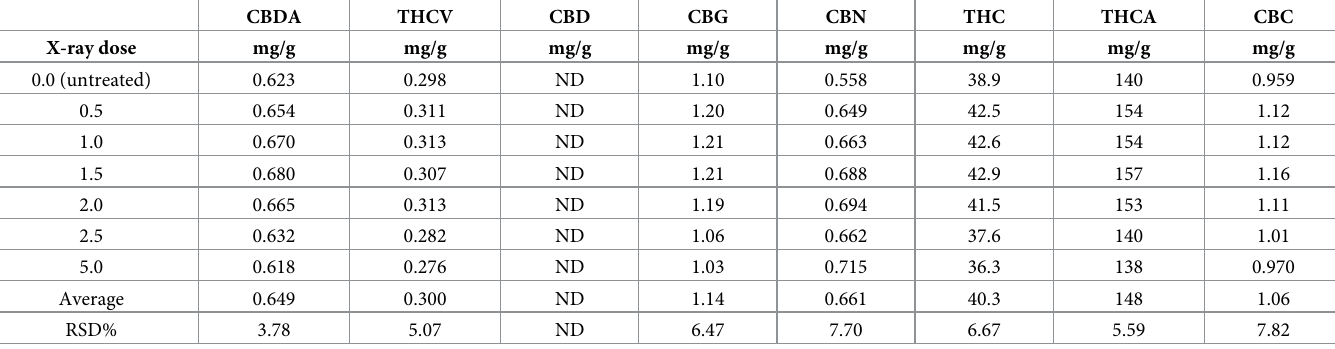
concentration of THCA/delta9-THC at different levels are mainly due to the natural inhomo- geneity of the cannabis flower sample and the measurement uncertainty for all analytical methods. A trend test across different treatment groups was performed on STATA version 17.0 (StataCorp) for potential cannabinoids profile changes after X-ray irradiation. We set the level of significance as p < 0.05. No significant trends were observed for THCA and del- ta9-THC concentrations. Table 8. Cannabinoid concentration of flower samples before and after X-ray irradiation treatment at different dosage levels. CBDA THCV CBD CBG CBN THC THCA CBC X-ray dose mg/g mg/g mg/g mg/g mg/g mg/g mg/g